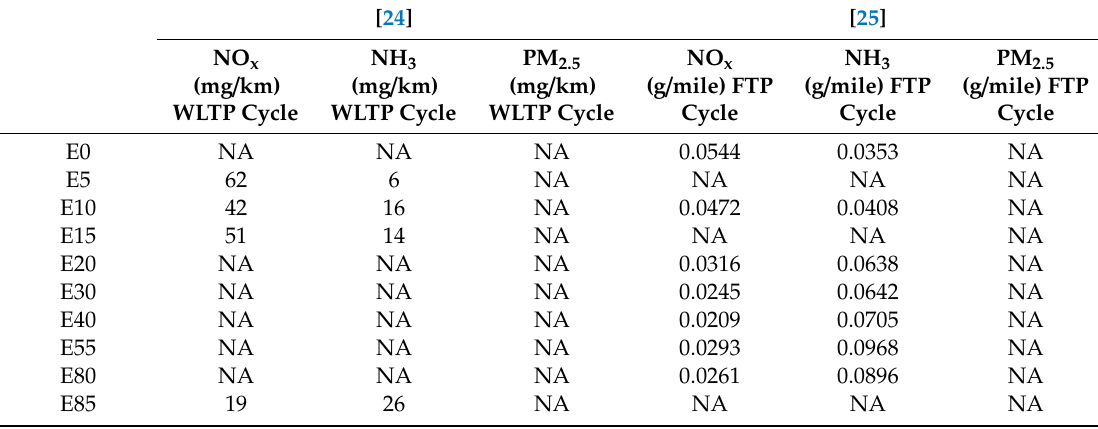
Table 4. Emission factors found in the literature for flex-fuel vehicles